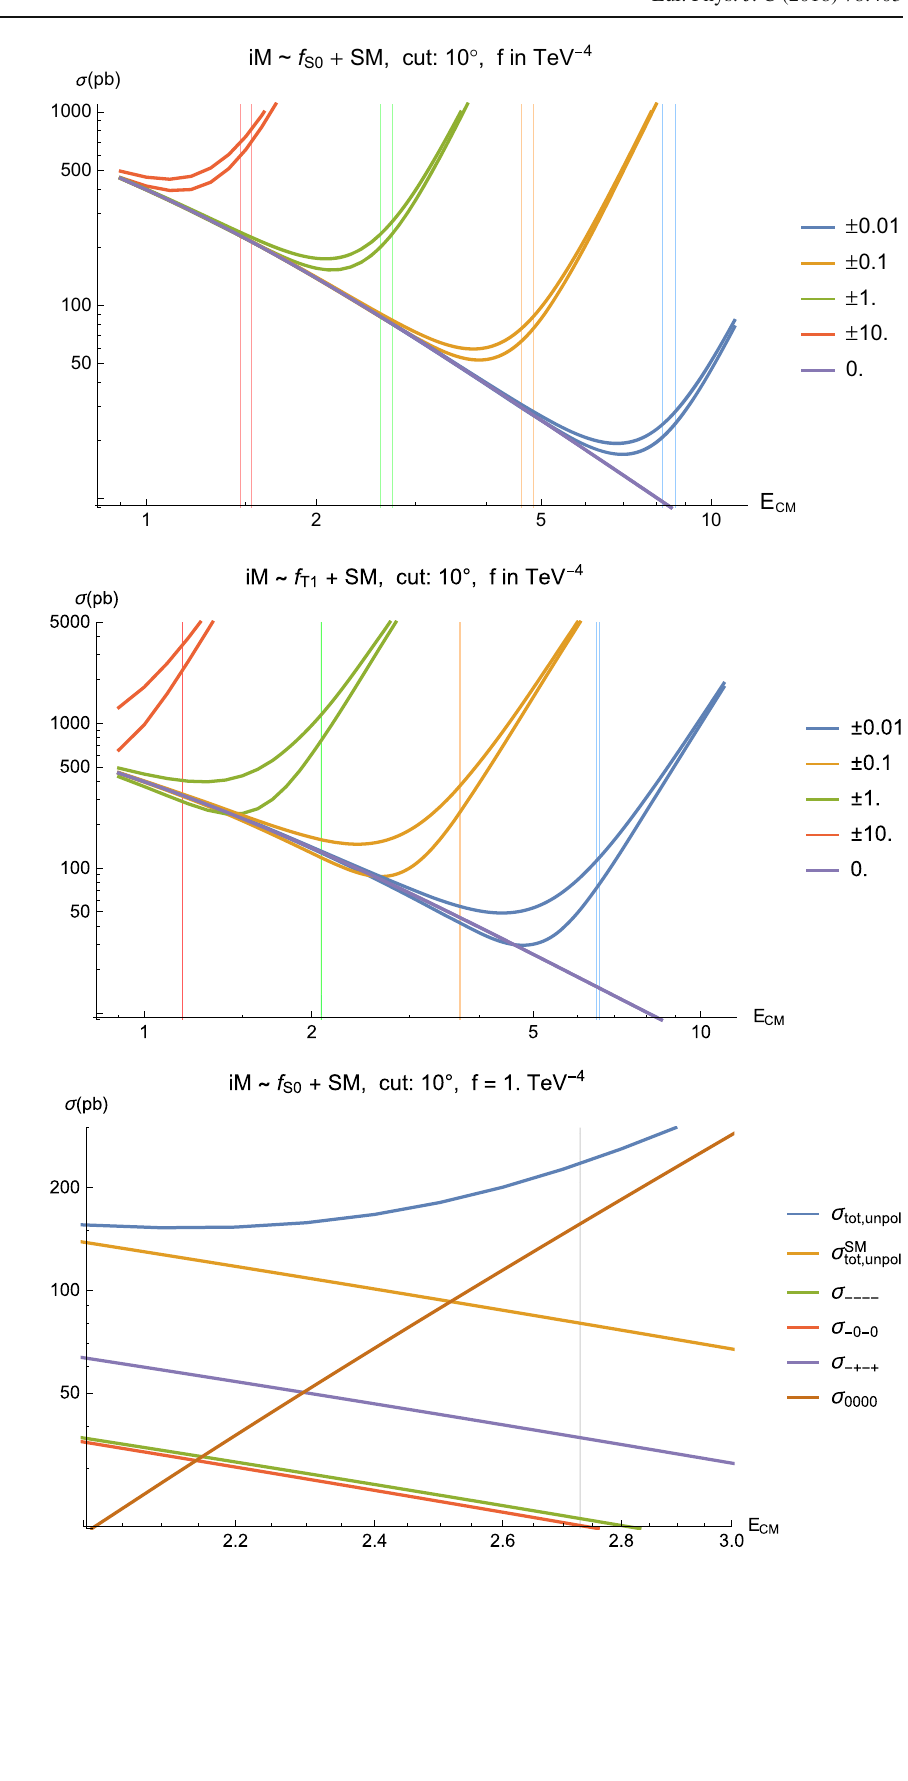
Fig. 8 Energy dependence of the total unpolarized W + W + √ s , in cross sections ( E CM ≡ TeV) for a chosen set of f S 0 values. Vertical lines denote the √ s U for each value of f lowest (color correspondence). There is no color distinction between the signs, upper lines (and hence √ s U limits) correspond stronger to negative values of f